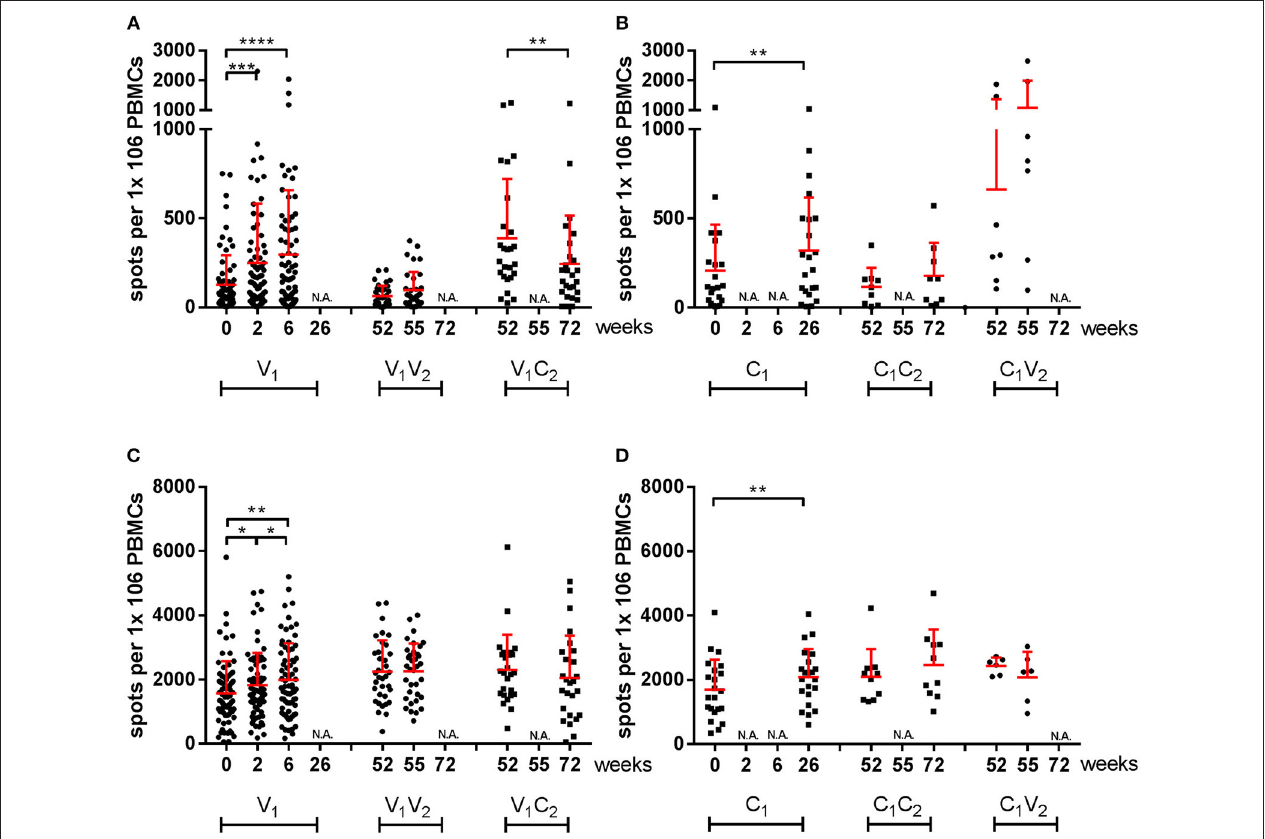
FIGURE 4 | IFN- γ -specific responses of influenza virus-stimulated and SEB-stimulated PBMCs by ELISpot. Spots per million PBMCs of A(H1N1)pdm09 virus-specific (A,B) and SEB-induced (C,D) IFN- γ responses by ELISpot in vaccinated individuals and individuals of the control group during season 1 and season 2. In red the mean and SD of each data set is depicted. ELISpot data were analyzed with Wilcoxon matched-pairs rank test. •vaccinated, (cid:4) controls * P < 0.05, ** P < 0.01, *** P < 0.001, **** P < 0.000,1N.A. not